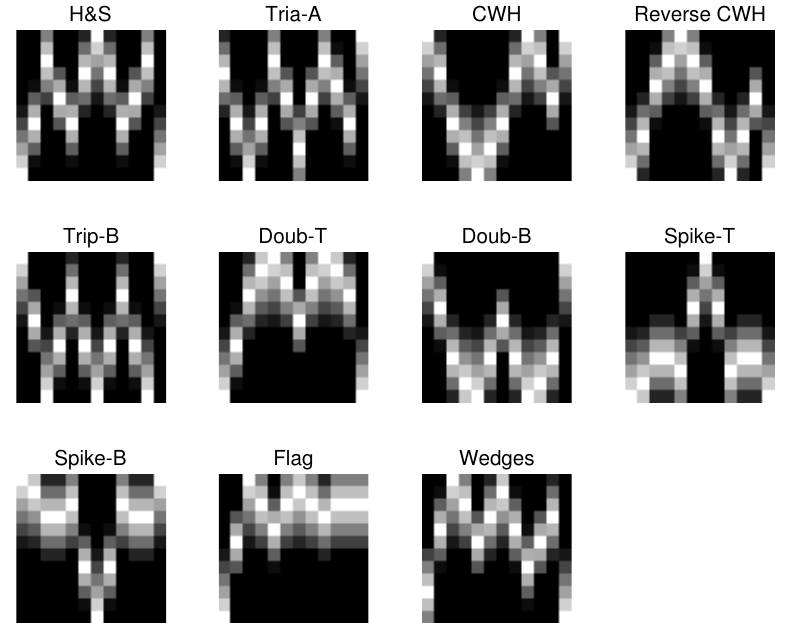
Figure A2. The representation of the N-equal-part TG.